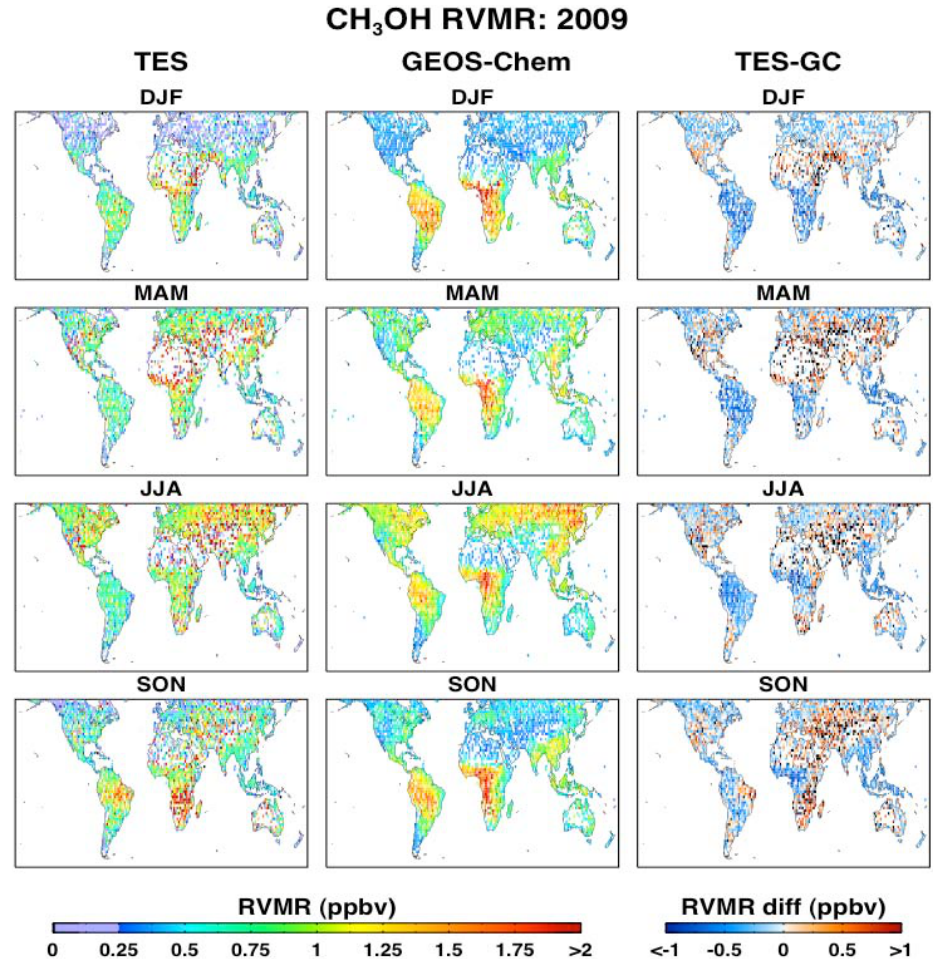
Fig. 11. Seasonally averaged CH 3 OH RVMR on a 2×2.5° grid for 2009. Left panels: retrieved values from TES. Midde panels: simulated values from GEOS-Chem with TES averaging kernel applied. Right panels: